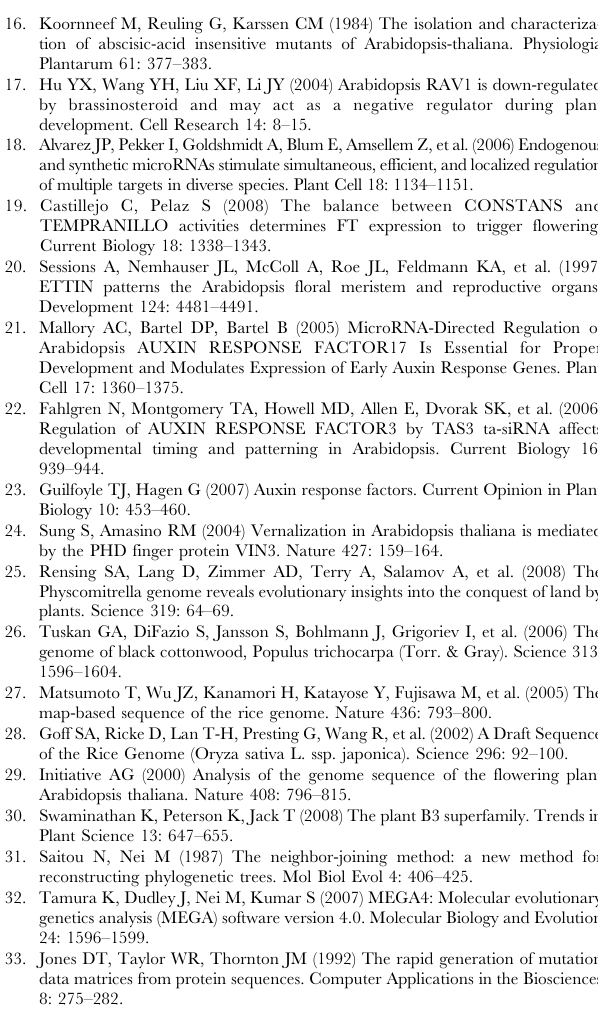
Table S5 List of B3 genes found by additional resources and putative domain found. List of the additional B3 genes found by Swaminathan et al. [30] for Arabidopsis and rice. Identification of domain and E-value was conducted in Pfam analysis. Genes with putative B3 domains or other DUF domain with not significant E- value were not included in our analysis. Asteristics represents pseudogenes described by TAIR.